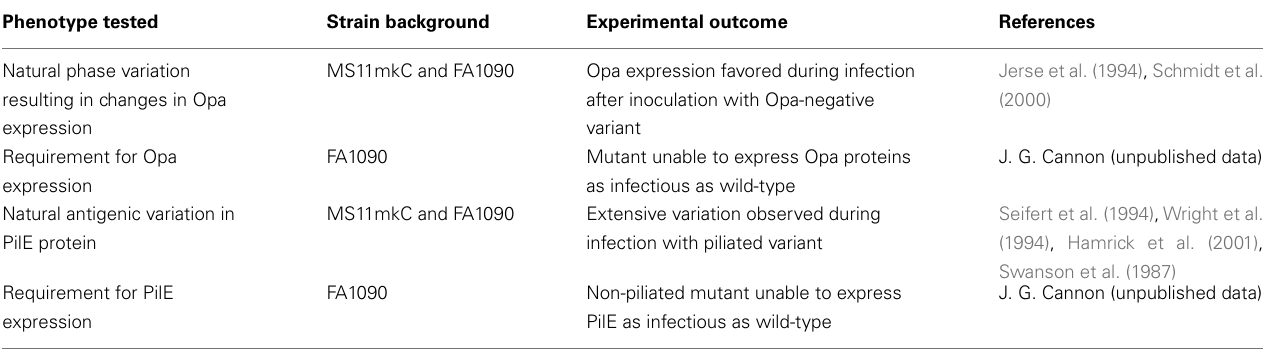
Table 3 | Effects of opacity protein (Opa) and pilin (PilE) expression on experimental